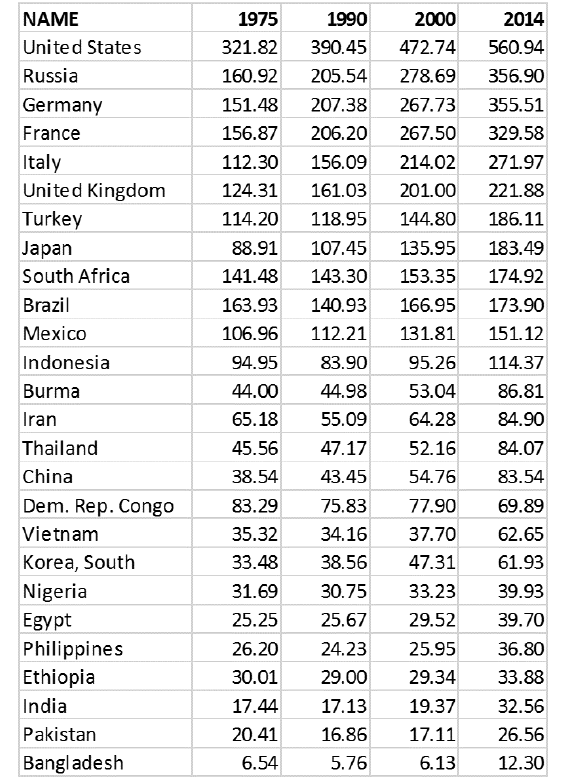
Figure 6: Estimated amount of built-up area pro-capita in the years 1975,1990, 2000 and 2014 in Countries with more than 50 millions of